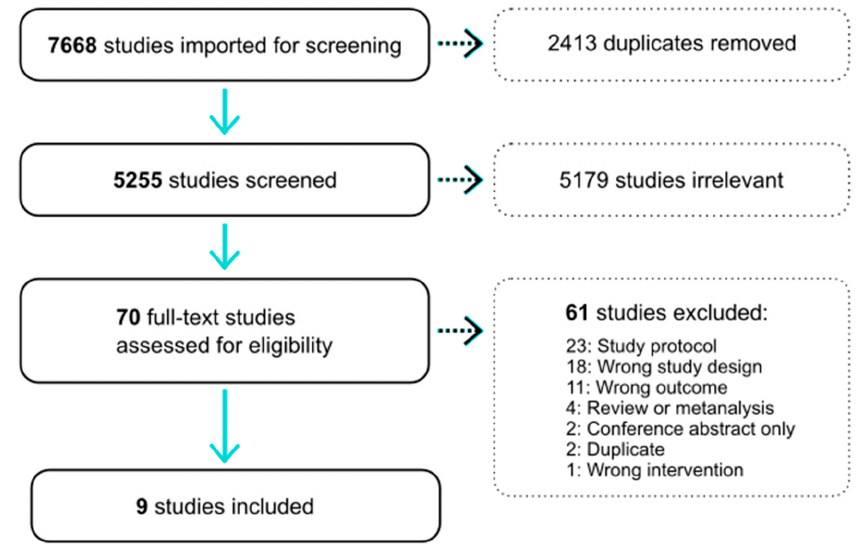
Figure 1. Flow chart depicting the literature search process.